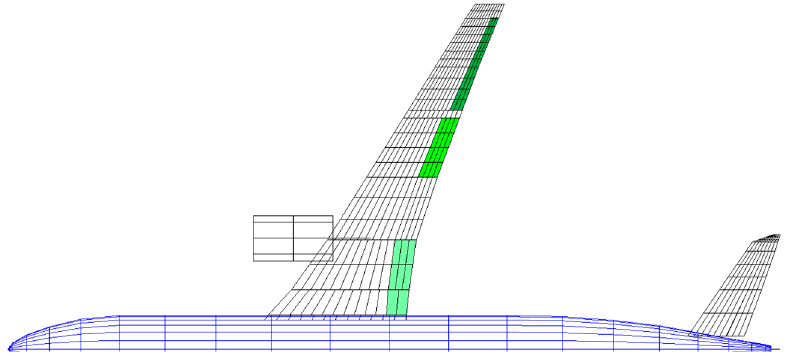
Figure 29. Deflected control surfaces using the enhanced MLA algorithm.